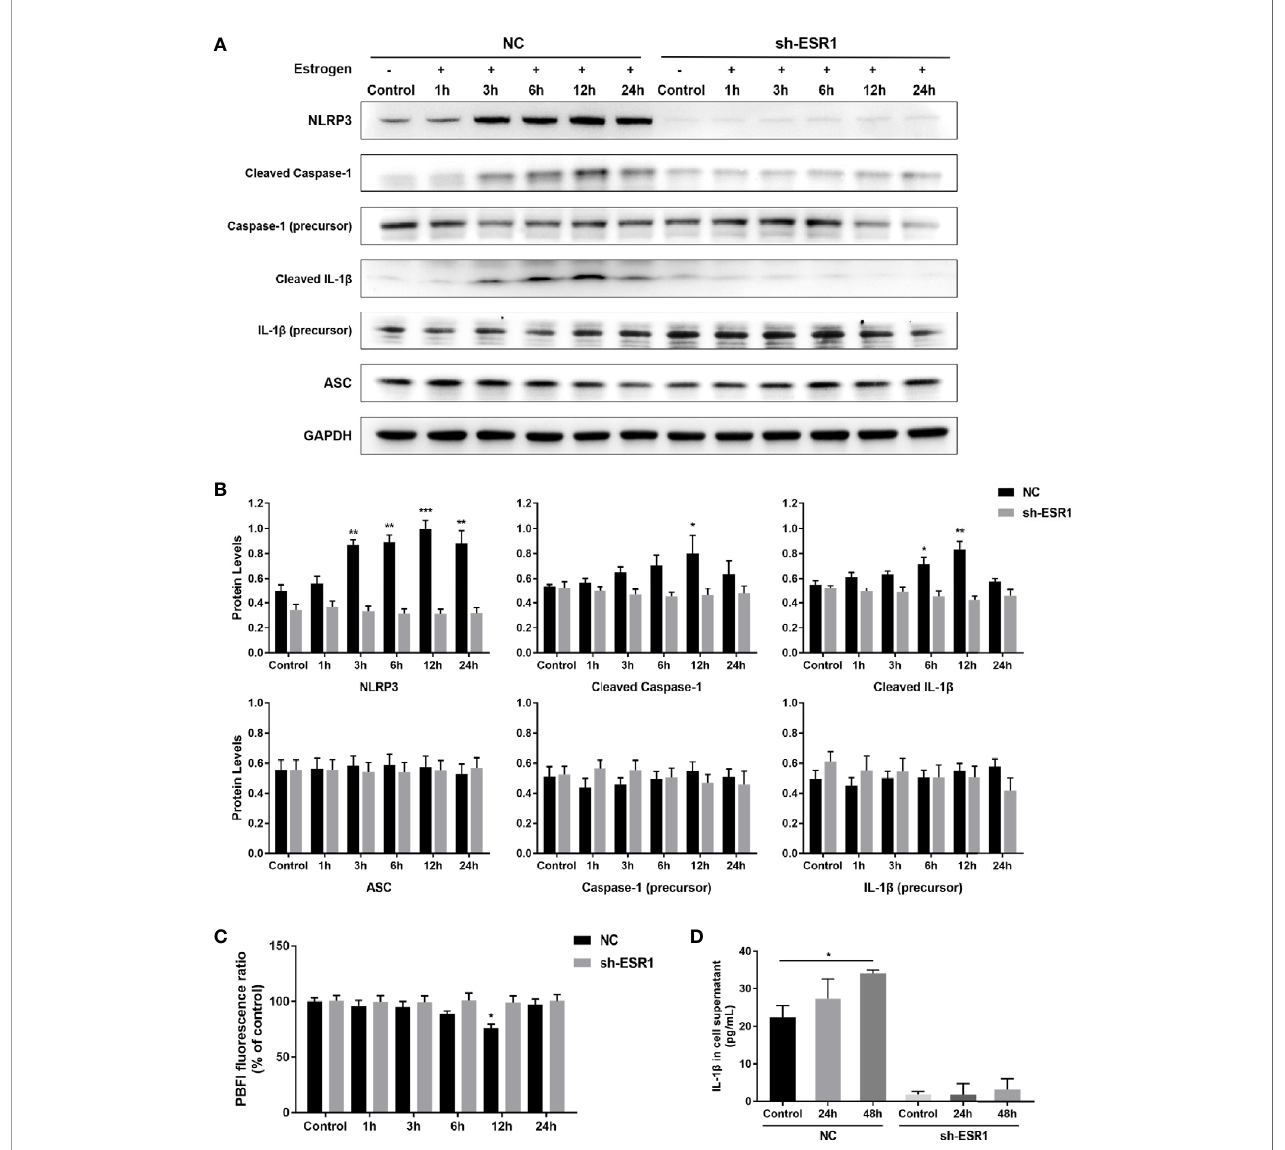
FIGURE 4 | The NLRP3 in fl ammasome pathway was activated by estrogen via ER- a . (A) Western blot analysis of NLRP3, cleaved caspase-1, caspase-1 precursor, cleaved IL-1 b , IL-1 b precursor, and ASC in P815 cells treated with 100 pmol/mL b -estradiol for 1 h, 3 h, 6 h, 12 h, and 24 h. (B) Quanti fi ed results of western blot assays. (C) Intracellular concentration of K + was determined by the ratio of the fl uorescence intensities obtained by exciting PBFI at 340/380 nm wavelengths while monitoring emission at 500 nm, and presented as percent of untreated control. (D) The concentration of IL-1 b in the P815 cell culture supernatant was tested using ELISA. Data in (B – D) represent three independent experiments. Data are expressed as mean ± SEM. Statistics: ANOVA followed by Dunnett t-test. * P < 0.05, ** P < 0.01, *** P <